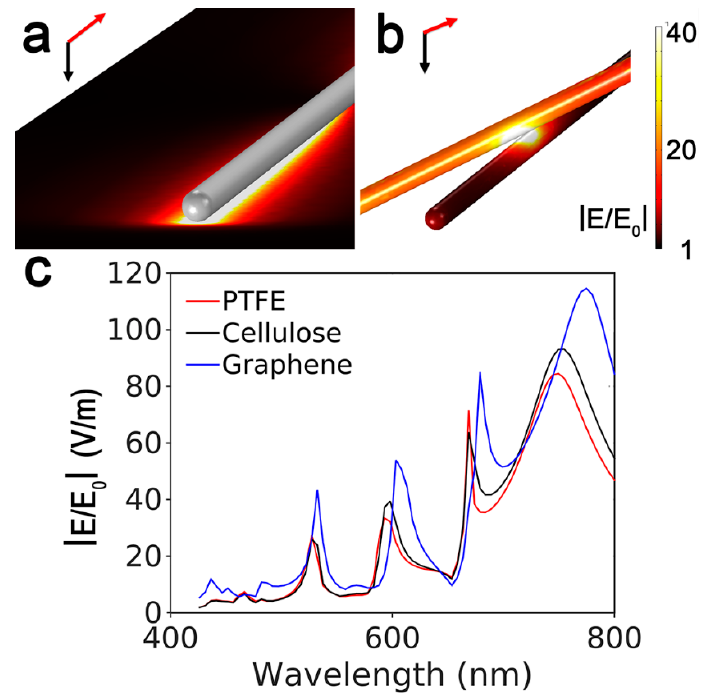
Figure 5. ( a ) FEM simulations of the E-field intensity in the proximity of a AgNW laying on a graphene surface. The E-field intensity is visualized for the plane corresponding to the G-paper surface while the wire is pictured as uniform grey color for better clarity. ( b ) The E-field intensity is visualized for two crossed AgNWs in the air. In this case, the E-field intensity on the wire surface is visualized. ( c ) Maximum E-field variation within the visible spectral range as simulated at the interfaces between a AgNW and graphene (blue), PTFE (red) and cellulose